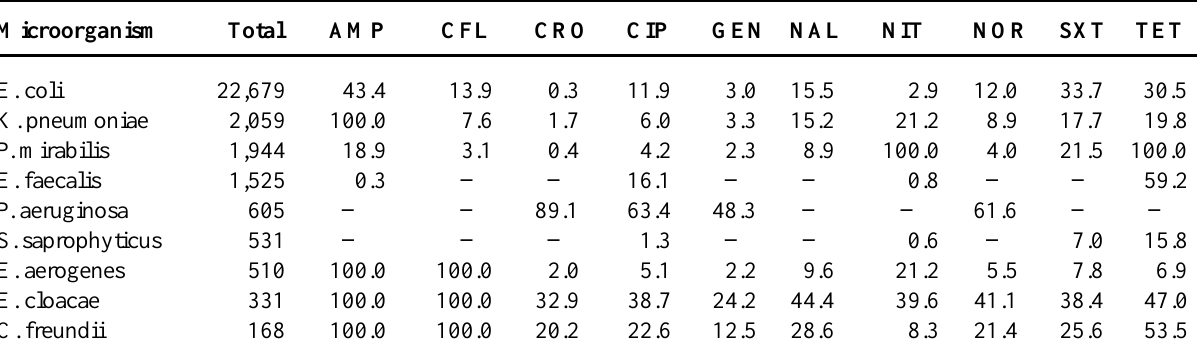
Table 2 – Resistance pattern (%) of the most prevalent microorganisms isolated from UTI in outpatients, years 2000 to 2003, São Paulo, Brazil.